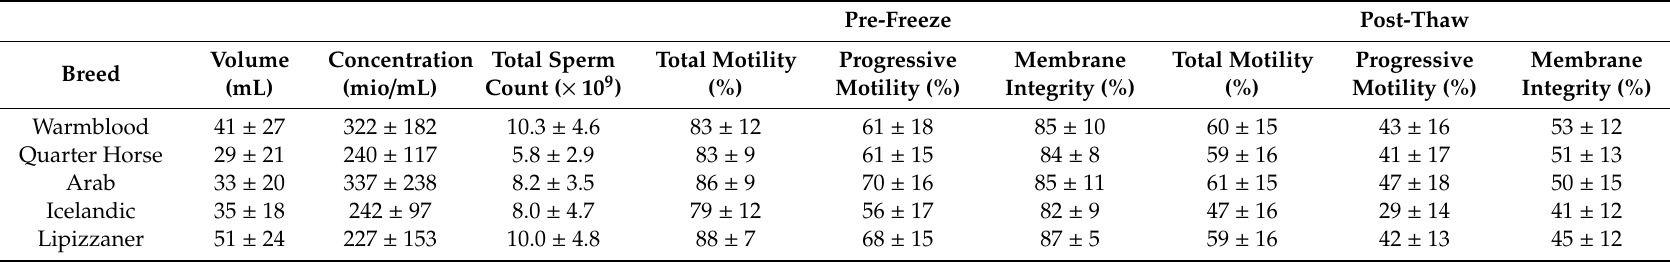
Table 2. Semen characteristics ( n = 134 stallions and 1012 ejaculates) for di ff erent breeds before freezing and after thawing (mean ± SD). Pre-Freeze